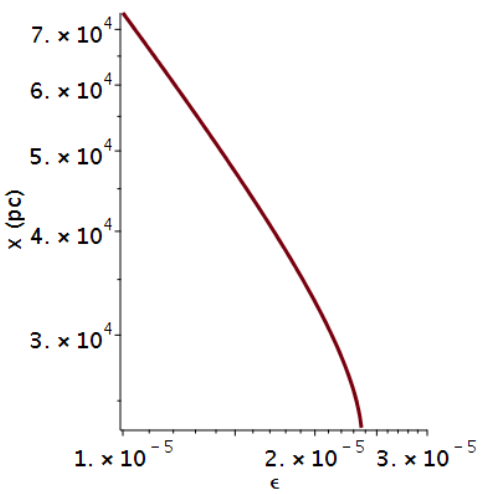
Figure 6. Length of the jet, x j , in pc, as a function of (cid:101) , with b as in Table